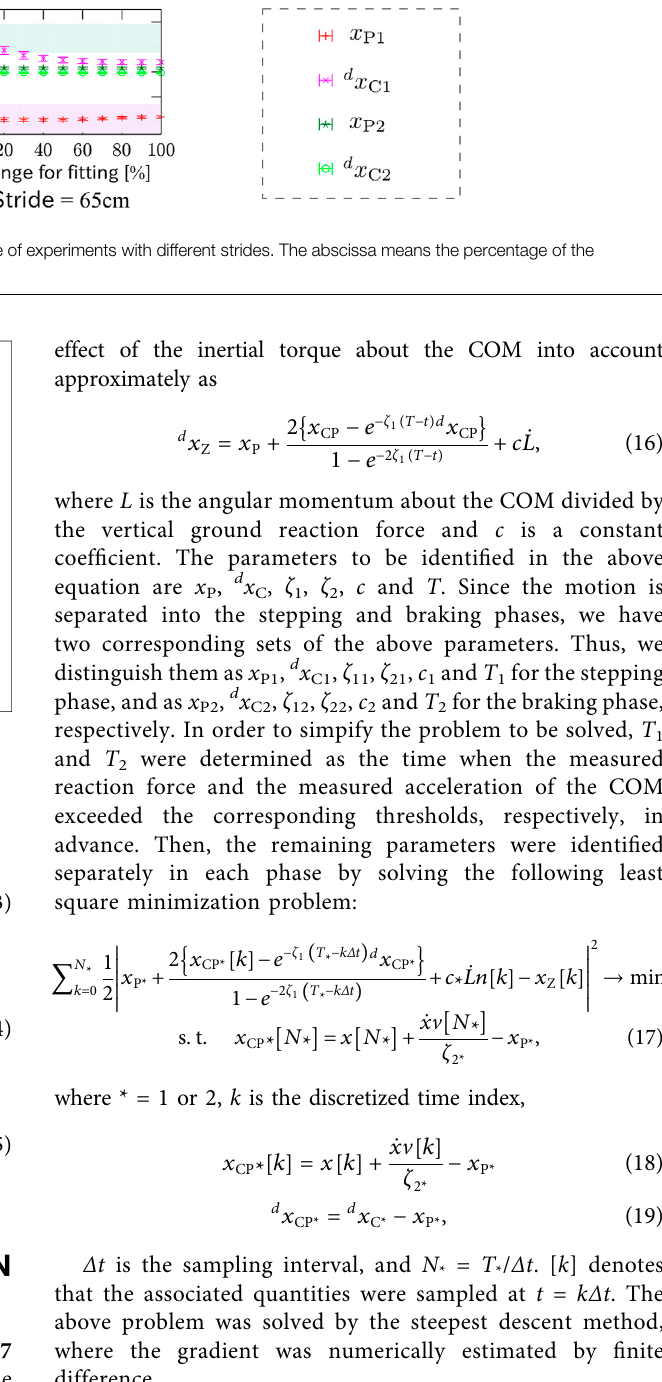
Frontiers in Robotics and AI |